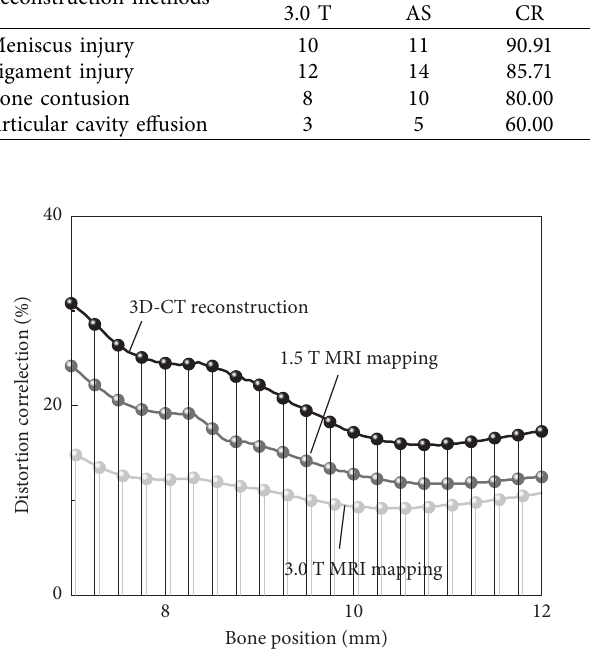
Figure 8: Distortion level for different reconstruction methods in at different recovery stages.